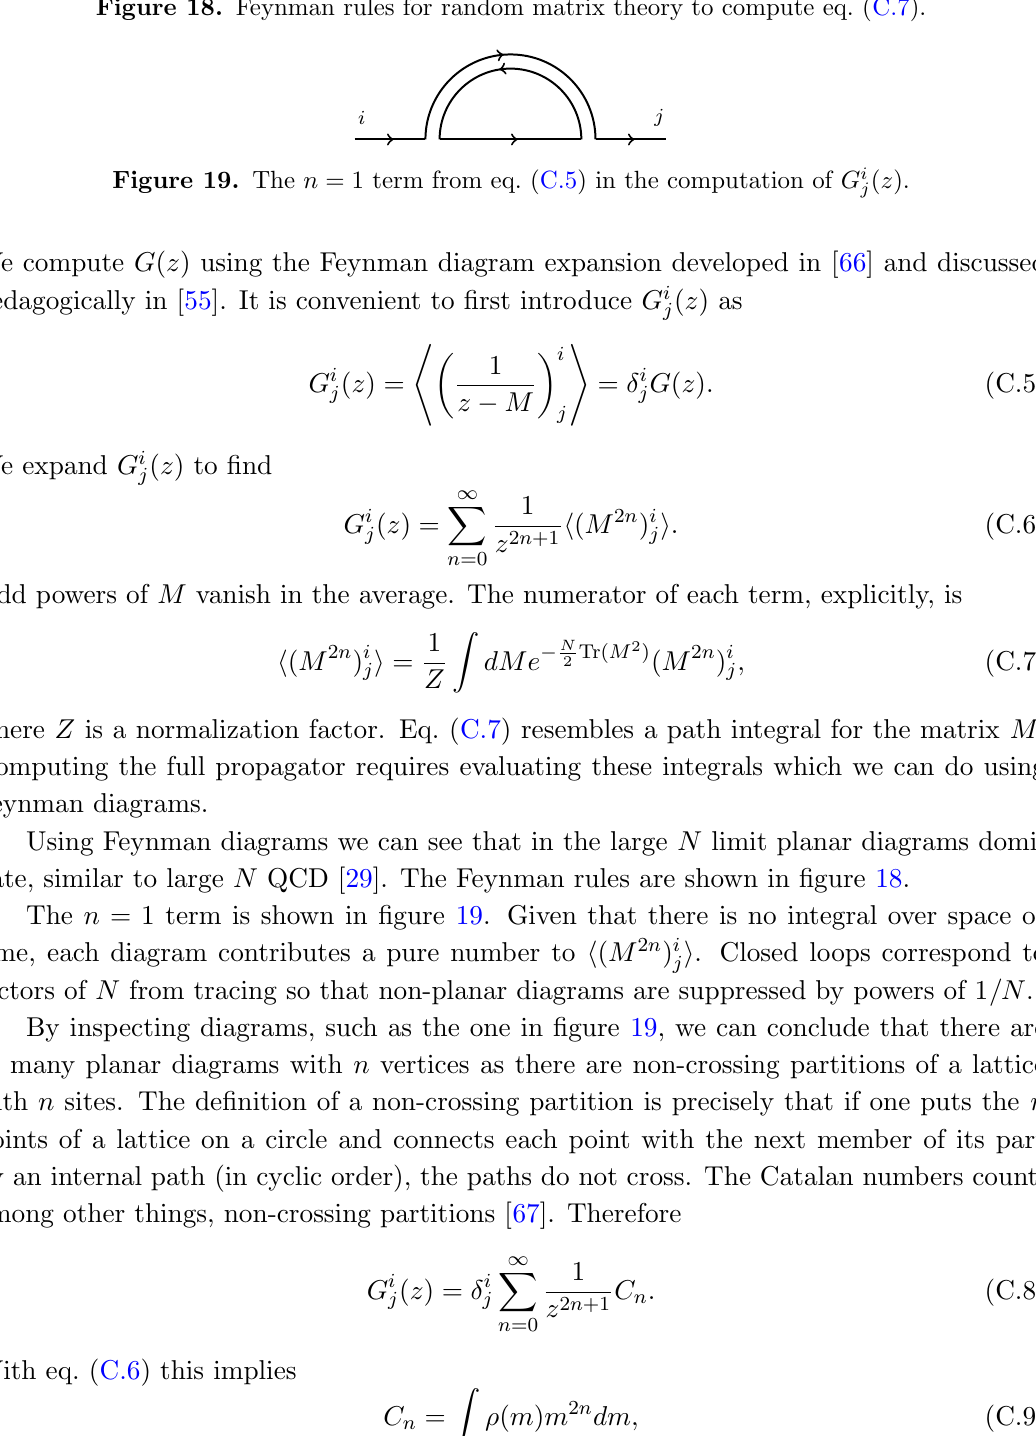
Figure 18. Feynman rules for random matrix theory to compute eq. (C.7).